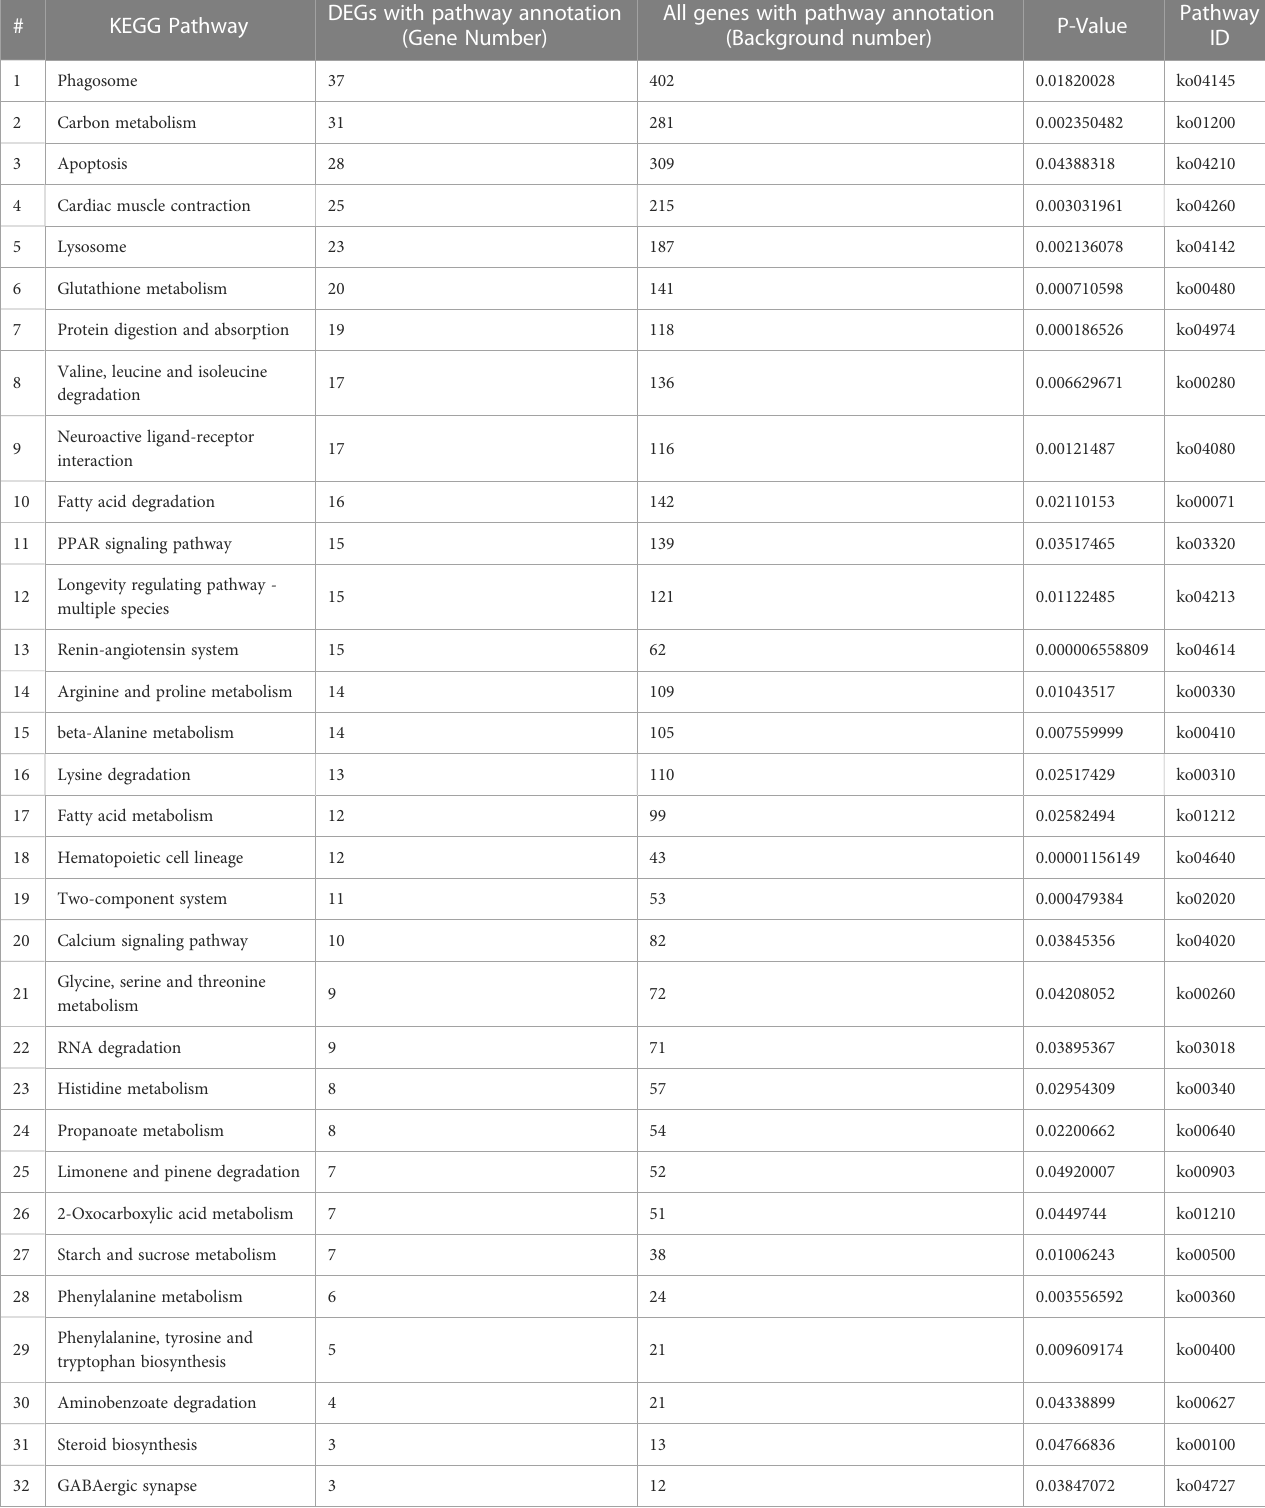
TABLE 2 Highly enriched KEGG pathways of DEGs in the H. cunea